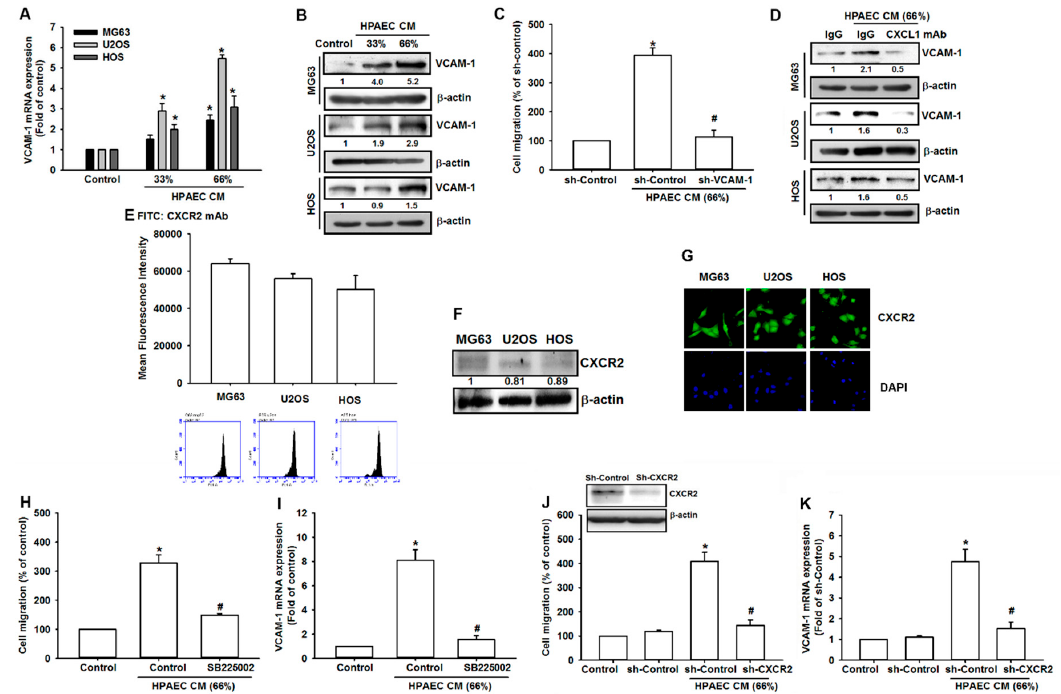
Figure 4. HPAECs CM promotes osteosarcoma cell mobility by upregulating VACM-1 expression. ( A , B ) MG63, U2OS and HOS osteosarcoma cells were incubated with increasing concentrations of HPAECs CM. Total mRNA and protein were extracted from the osteosarcoma cells and levels of VCAM-1 expression were detected by qPCR and Western blot. ( C ) MG63 cells were transfected with VCAM-1 shRNA and incubated with the indicated concentrations of HPAEs CM, and cell mobility was assessed by the Transwell migration assay. ( D ) MG63, U2OS, and HOS osteosarcoma cells were incubated with the indicated concentrations of HPAECs CM in the presence of CXCL1 neutralizing antibody or control IgG (1 μ g/mL). Total protein was collected and VCAM-1 expression was evaluated by Western blot. ( E – G ) Total protein were collected from the indicated cell lines, and CXCR2 expression was detected using flow cytometry, Western blotting, and immunofluorescence. ( H ) MG63 cells were pretreated with the CXCR2 inhibitor SB225002 for 90 min and seeded in the upper chamber of the Transwell apparatus; then the HPAECs CM was placed in the lower chamber, and cell migration was evaluated after 20 h. ( I ) MG63 cells were pretreated with the CXCR2 inhibitor SB225002, and then incubated with HPAECs CM for 24 h. Levels of VCAM-1 mRNA expression were determined by qPCR. ( J ) MG63 cells were transfected with CXCR2 shRNA and incubated with the indicated concentrations of HPAECs CM, and cell mobility was assessed by the Transwell migration assay. ( K ) MG63 cells were transfected with CXCR2 shRNA and incubated with the indicated concentrations of HPAECs CM for 24 h, and VCAM-1 mRNA expression levels were determined by qPCR. Results are expressed as the mean ± SD. * p < 0.05 compared with control or the control shRNA group. # p < 0.05 compared with the HPAECs CM-treated group.